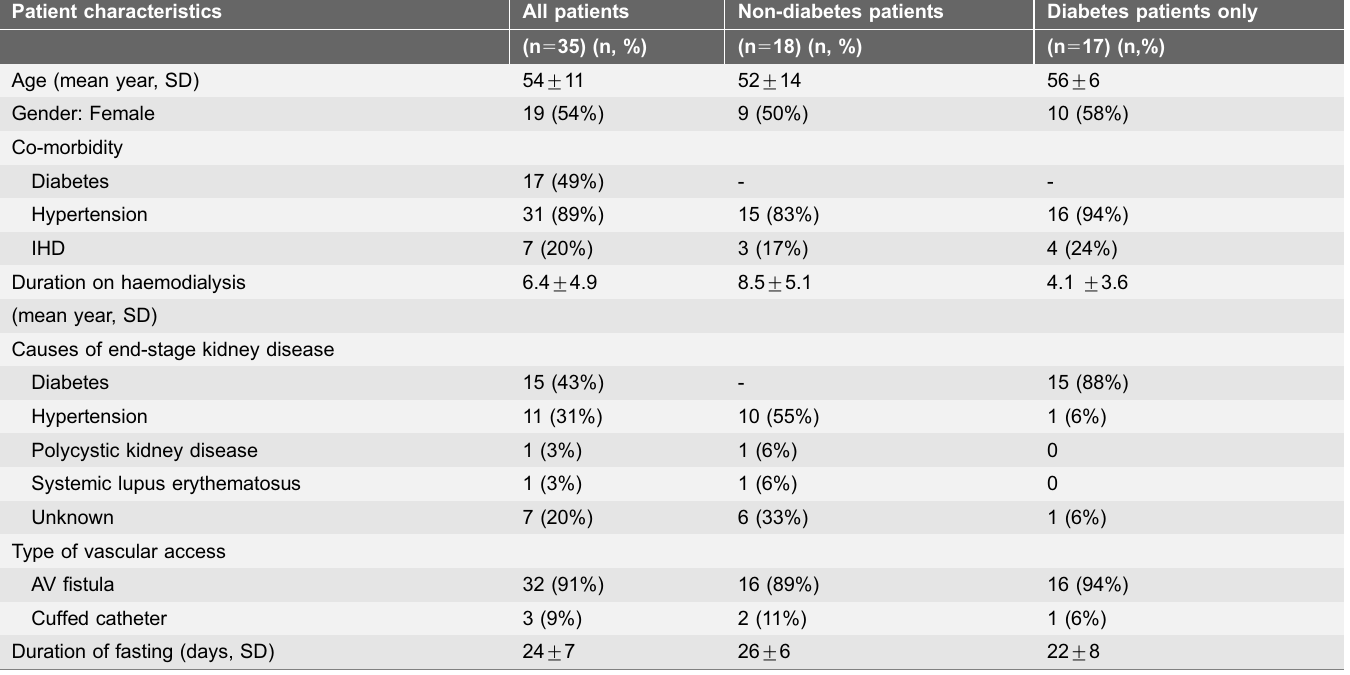
Table 1. Characteristics participants in the effects of voluntary Ramadan fasting in haemodialysis patient